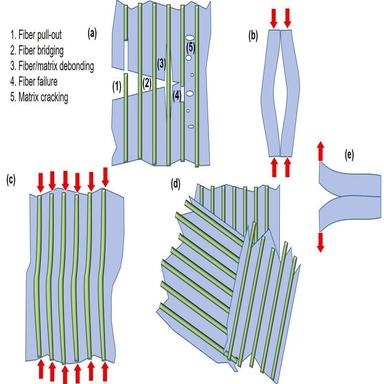
Schematic of damage mechanisms in fiber-reinforced composites; (a) in-plane damage, (b) buckling delamination, (c) micro-buckling, (d) pseudodelamination and (e) delamination.